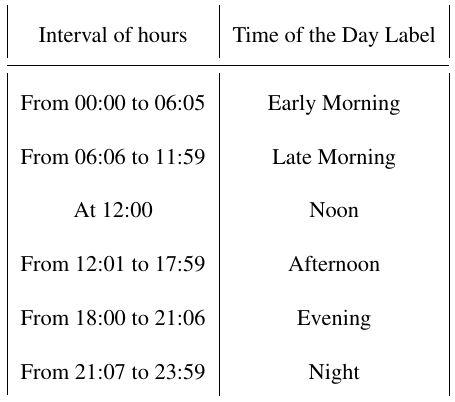
Table 2. US Part-Time of the Day by Local Time in 2018 Interval of hours Time of the Day